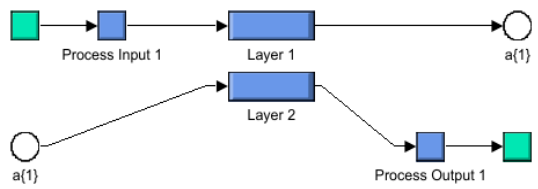
Figure 12. Simulink model of an ANN. Figure 13. Subsystem of an ANN. Figure 13. Subsystem of an ANN. Figure 13. Subsystem of an ANN. Figure 13. Subsystem of an ANN.